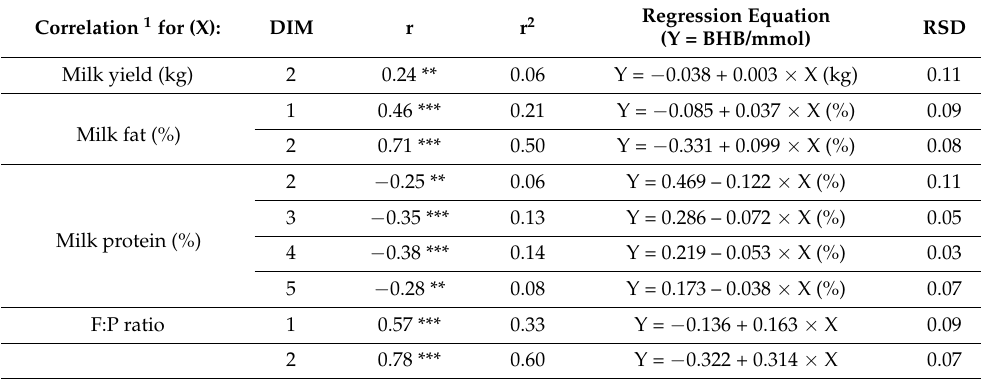
Table 7. Correlations and regression equations between milk yield, milk contents, or fat to protein content ratio (F:P ratio) and beta-hydroxybutyrate